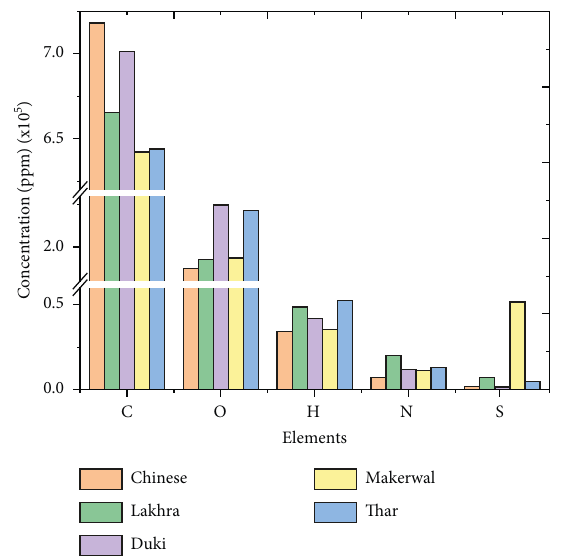
Figure 7: Concentration of major elements C H, N S, and O in the five coal